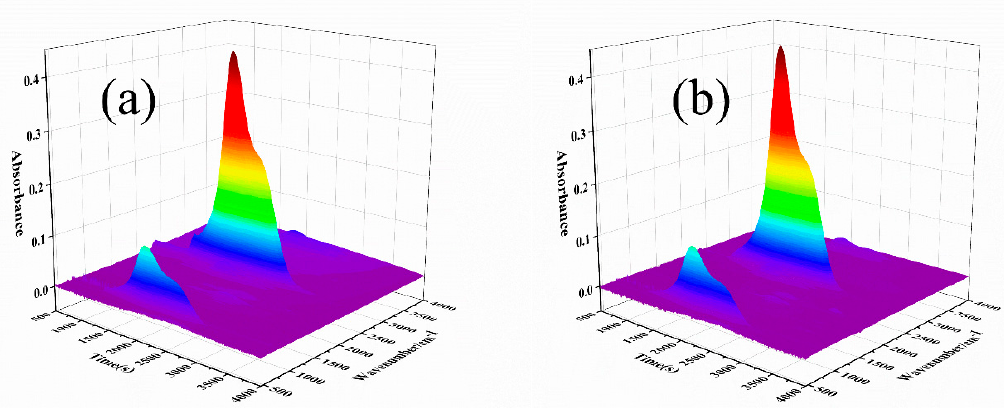
Figure 11. Three-dimensional TG-FTIR images of pyrolysis products of ( a ) PBa; ( b ) PBa/DQ-5%.